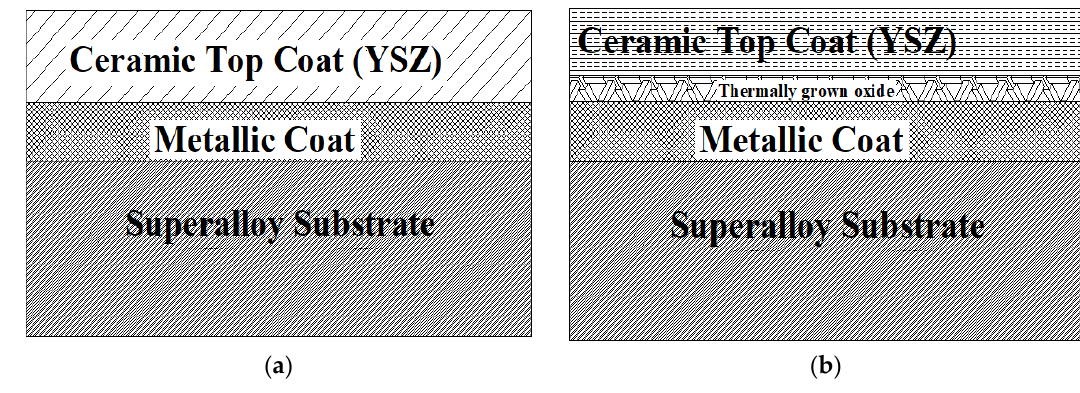
Figure 1. Showing the components of thermal barrier coating (TBC) ( a ) before oxidation ( b ) after oxidation with the inclusion of thermally grown oxide (TGO). oxidation with the inclusion of thermally grown oxide